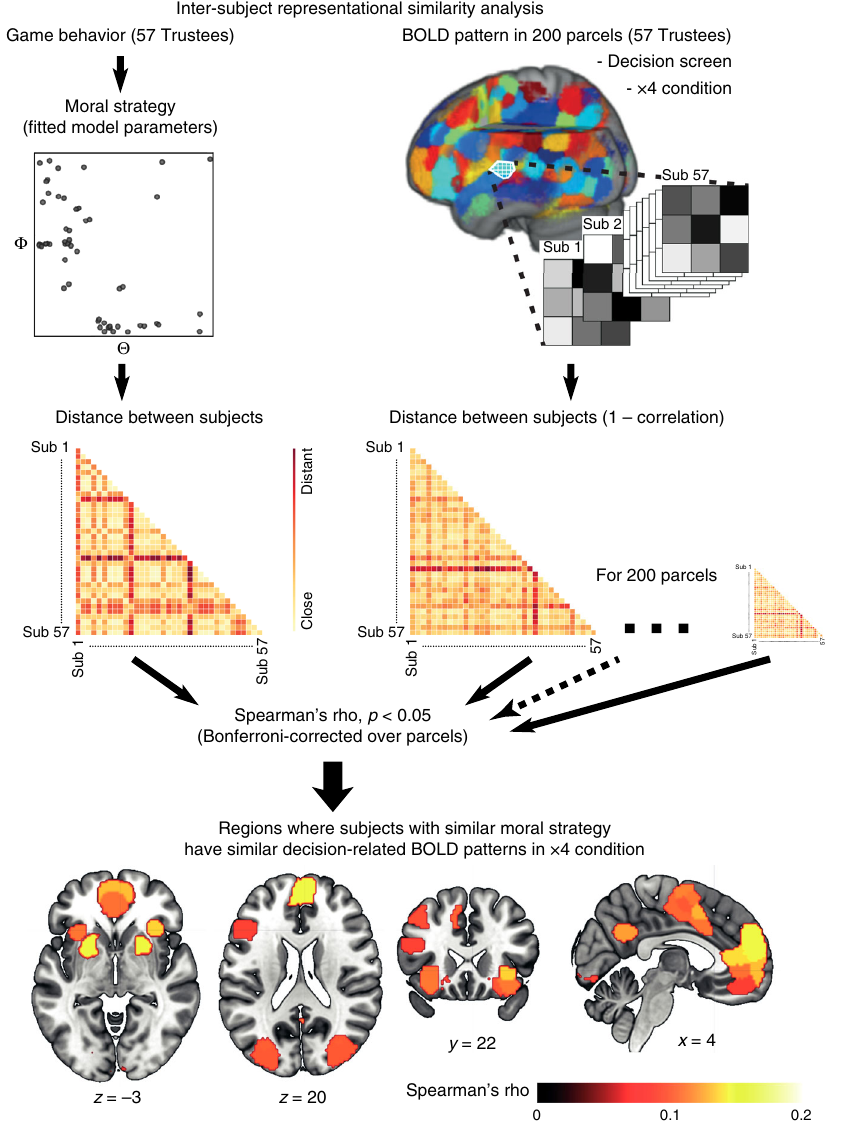
Fig. 3 Inter-subject representational similarity analysis. Inter-subject RSA revealed brain parcels where players with similar moral strategy had similar BOLD patterns in the Decision screen of the ×4 condition. Since this condition yielded identical behavioral predictions for guilt-averse, inequity-averse, and morally opportunistic participants, neural pattern differences likely re fl ect the psychological computations underlying these moral strategies. Brain slice numbers represent coordinate in MNI